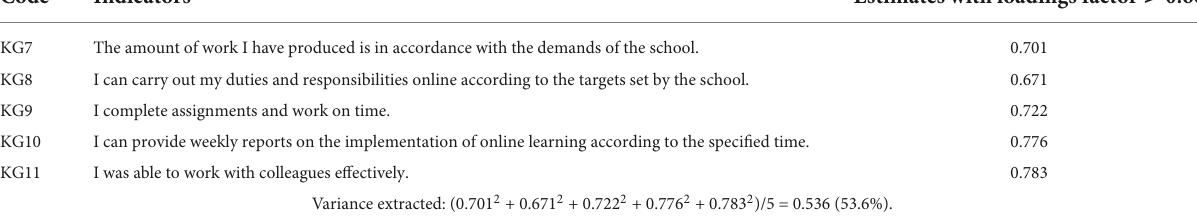
TABLE 9 The loading factor from the indicator to the teachers’ performance variable during the COVID-19 pandemic. Code